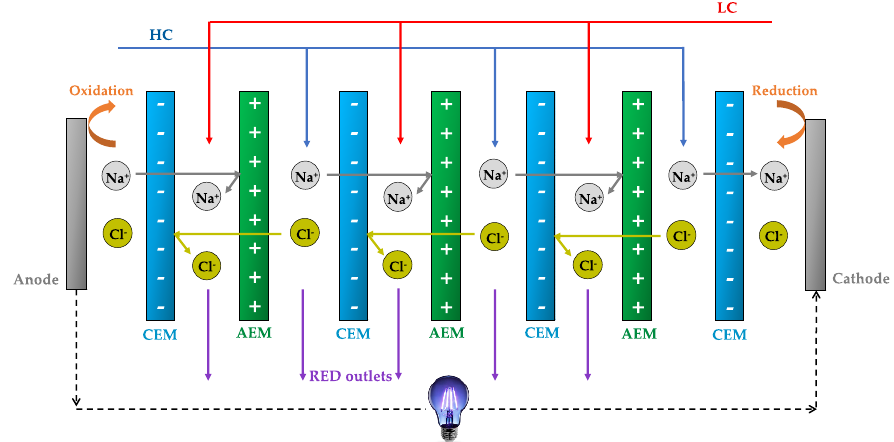
Figure 1. A reverse electrodialysis (RED) stack—schematic diagram (HC—high salt concentration; LC—low salt concentration).